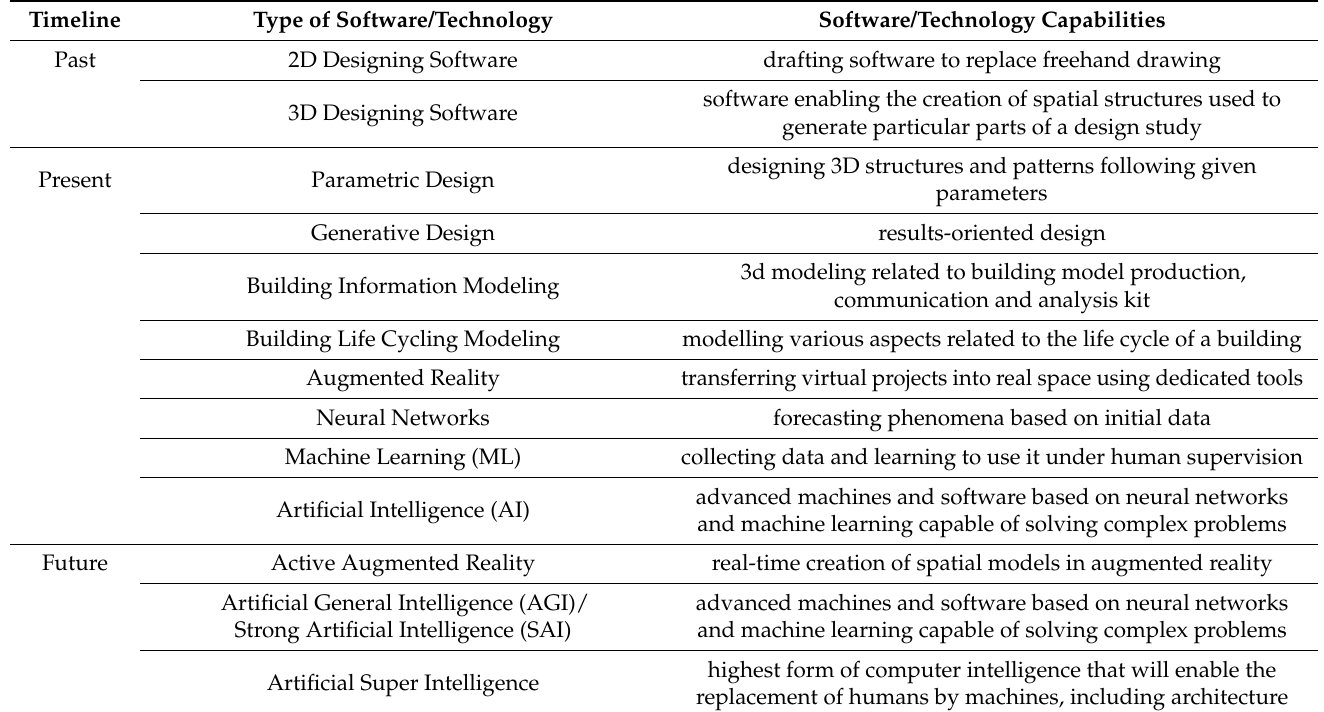
Table 1. Development of software and technology for computer